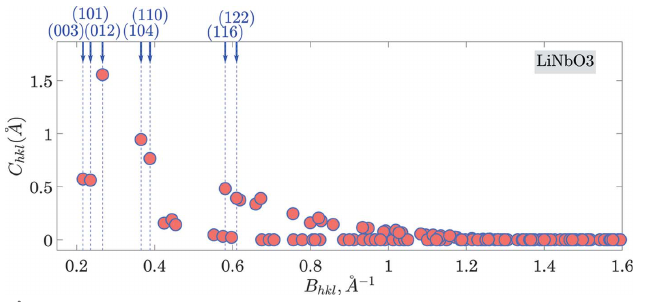
Figure 15 Same as Fig. 4 but for the case of LiNbO 3 .